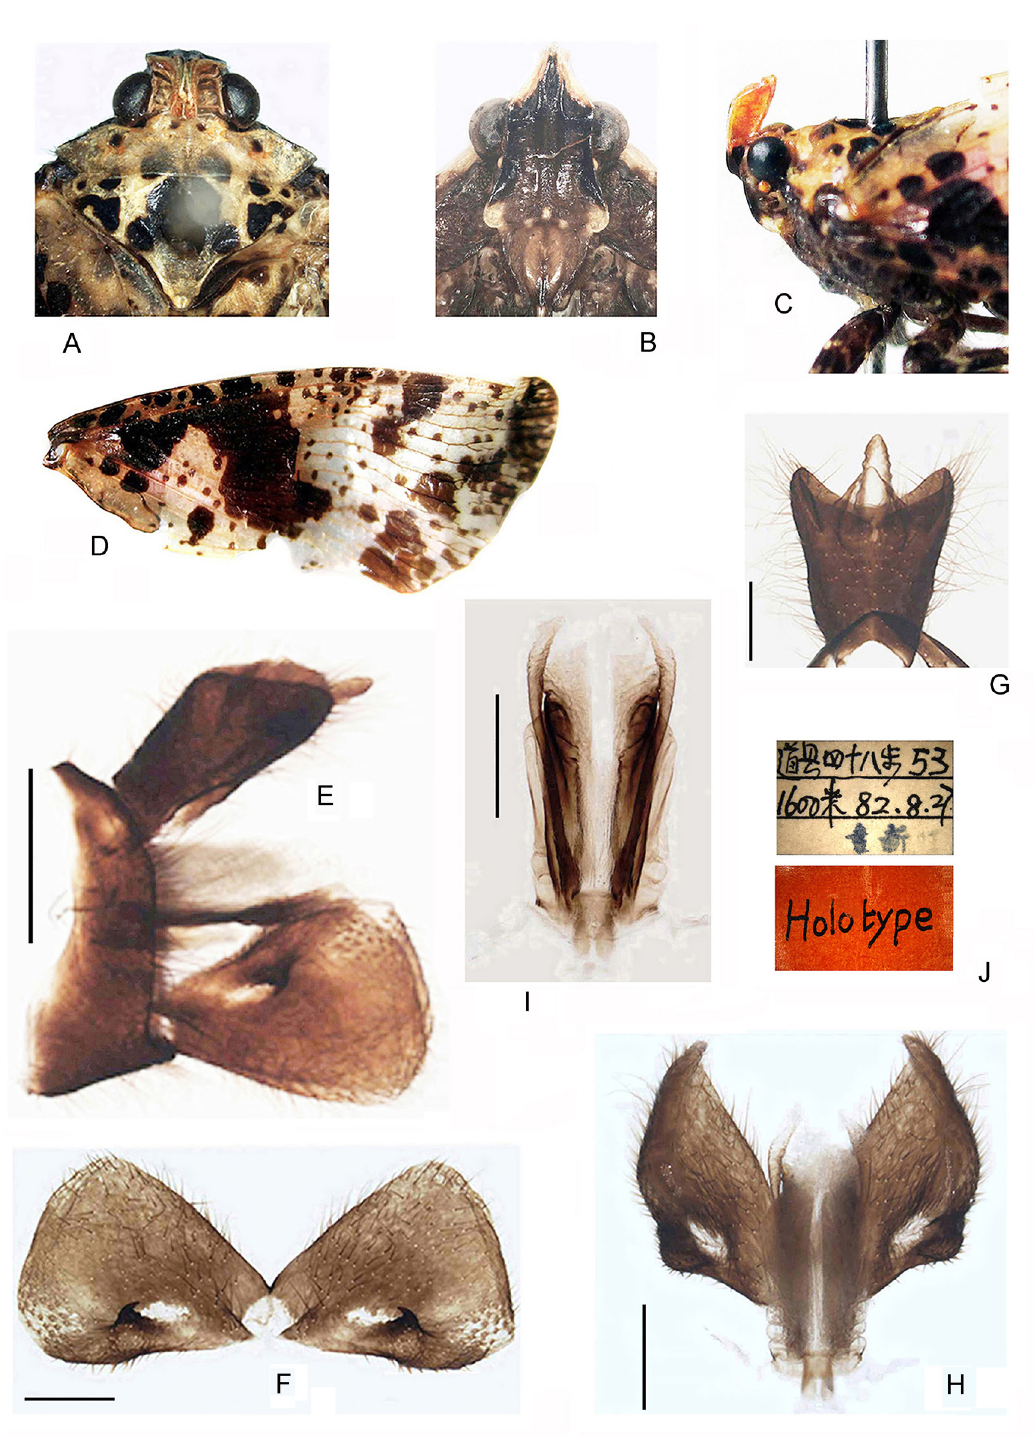
Fig. 3. Limois hunanensis Chou & Wang, 1985, holotype, adult male. A . Head and thorax, dorsal view. B . Face. C . Head and thorax, left lateral view (showing reflexed protuberance of the vertex). D . Forewing. E – I . Male genitalia. E . Left lateral view. F . Gonostylus, ventral view. G . Anal tube, dorsal view. H . Aedeagus and gonostylus, dorsal view. I . Aedeagus, ventral view. J . Labels. Scale bars: E = 1.0 mm; F–I = 0.5